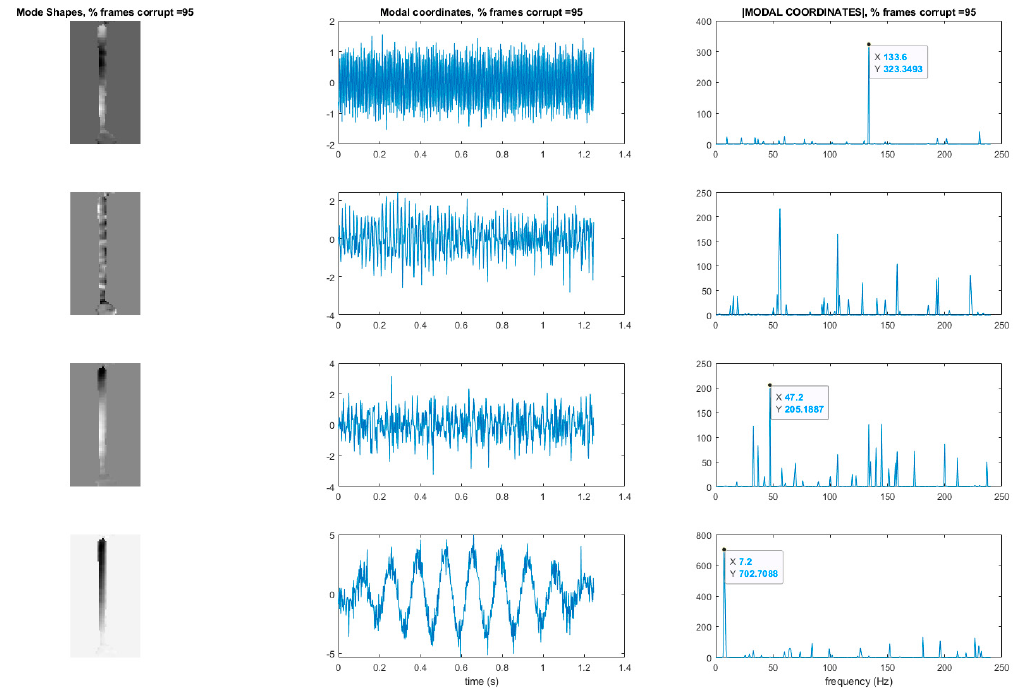
Figure 19. Mode shapes and modal coordinates for the case of L1 reconstruction after the PCA step. Results are shown for the case of 95% of the frames randomly removed. Y -axis of the modal coordinate and the magnitude of the fft(modal coordinate) plots are arbitrarily scaled displacement.